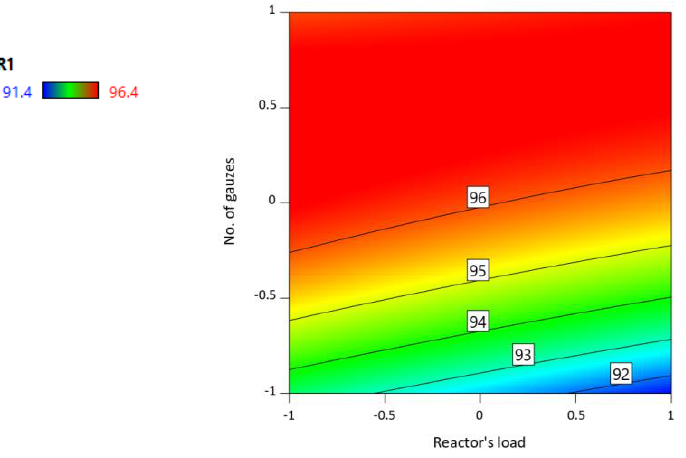
Figure 4. Interaction effect between the reactor’s load ( X 1 ) and the number of catalytic gauzes ( X 3 ) on ammonia oxidation efficiency ( R 1 ) by contour plot.